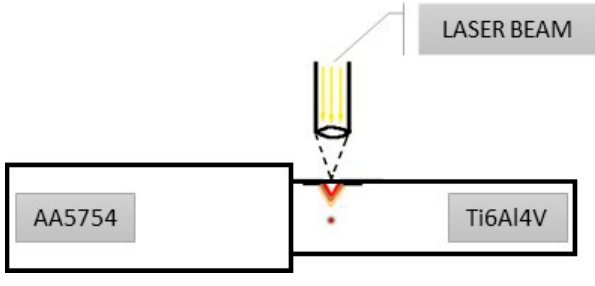
Figure 1. Scheme of laser welding on AA5754/Ti6Al4V.